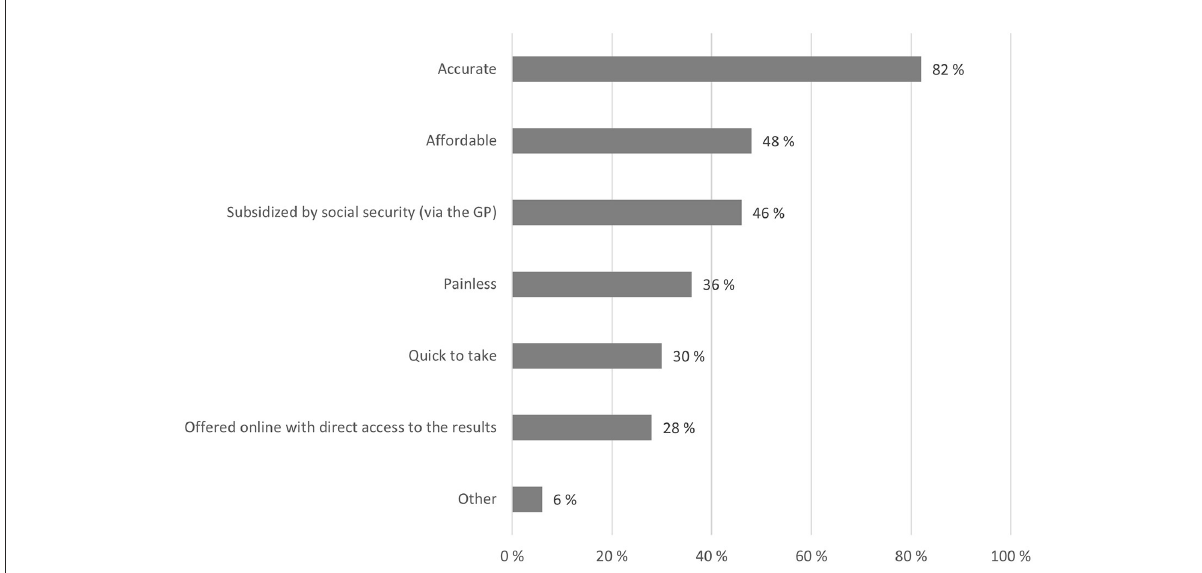
criteria for a good brain health test (price, invasiveness etc.), accuracy was rated as most